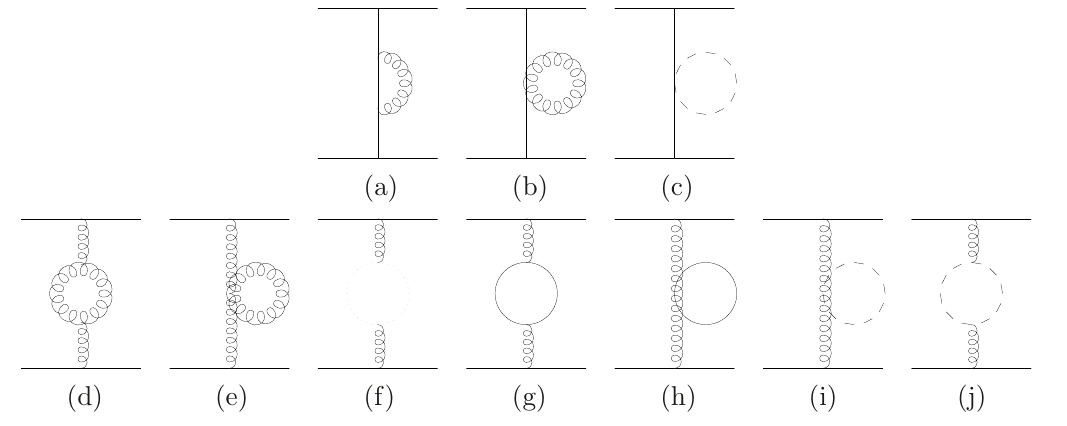
( q ⊥ ). In addition to the conventions C